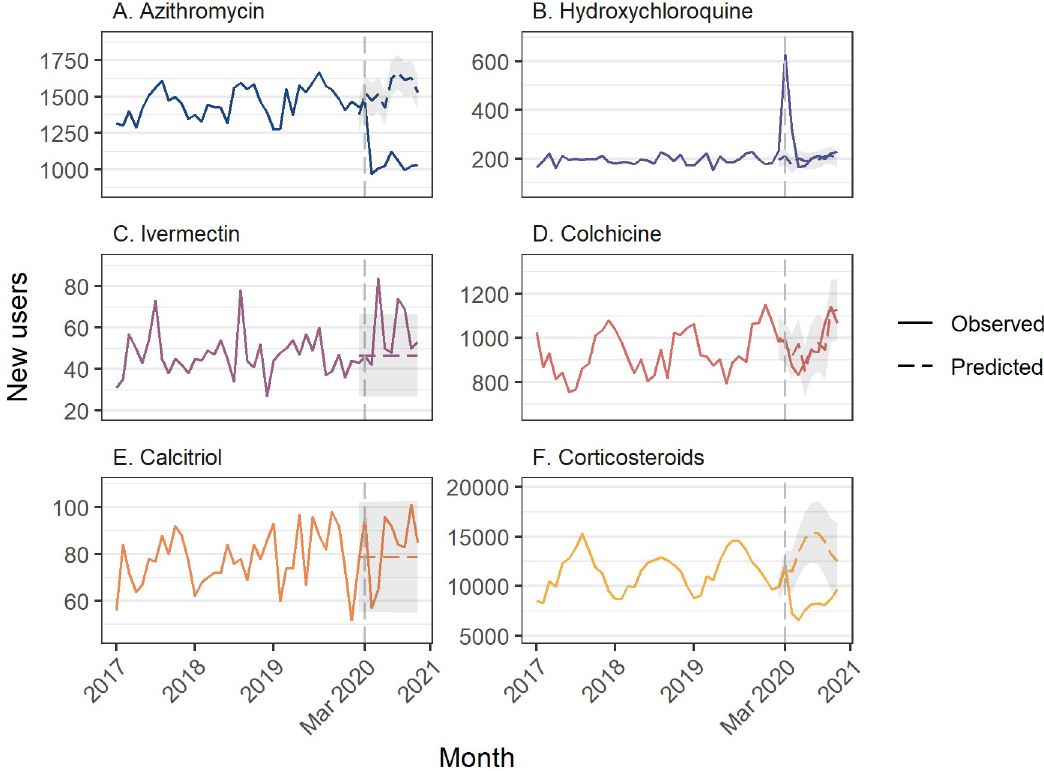
Fig 3. Number of new users of each medicine class of interest estimated using a 10% sample of PBS dispensing claims data. New user = new dispensing without a previous dispensing in the past 360 days. Grey shaded area = 95% confidence interval for predicted